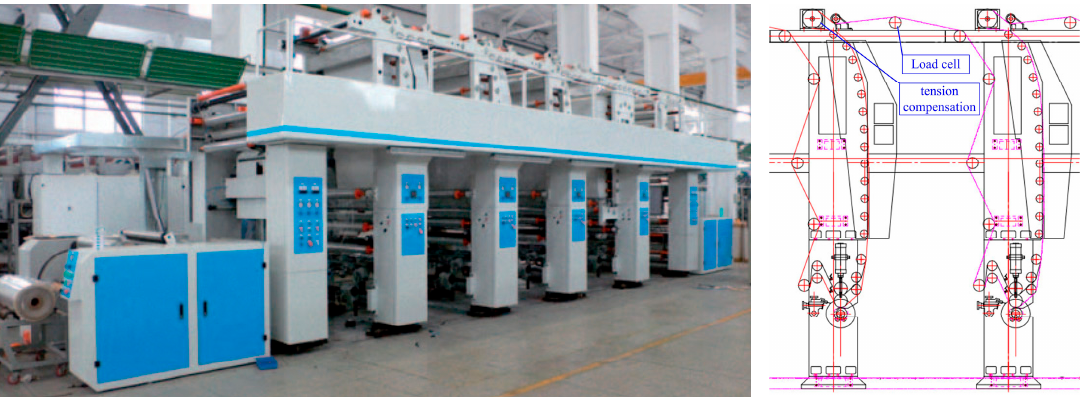
Figure 3. Gravure printed electronics experimental setup.